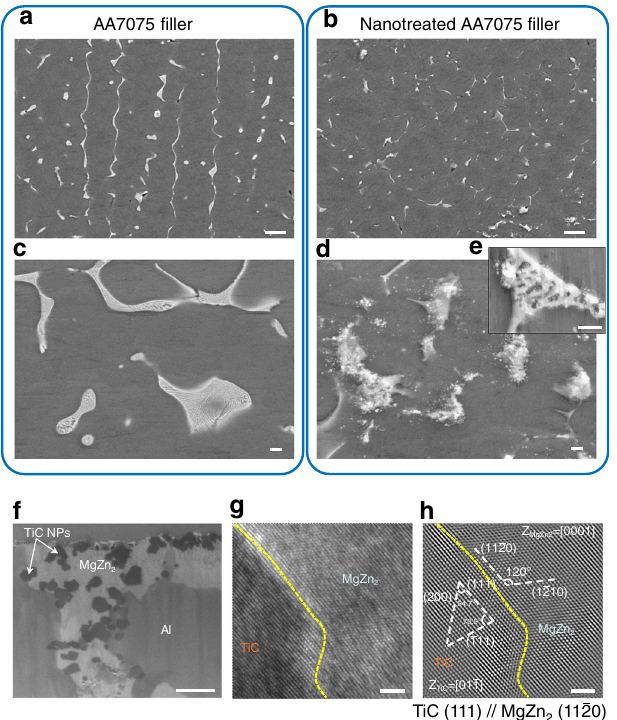
Fig. 3 SEM characterization of horizontal weld bead cross-sections presented in Fig. 2 of pure AA7075 and nano-treated AA7075 melting zones. a and c Secondary phase microstructure of a melting zone welded with AA7075 fi ller material. b , d and e Modi fi ed secondary phase of AA7075, welded with nano-treated fi ller material. f TEM sample showing the cross-section view of the modi fi ed secondary phase by nano-treated fi ller material. g A typical high resolution TEM image of the interface between TiC nanoparticle and secondary phase (identi fi ed as MgZn 2 ). h Fourier- fi ltered high resolution TEM image corresponding to g . Scale